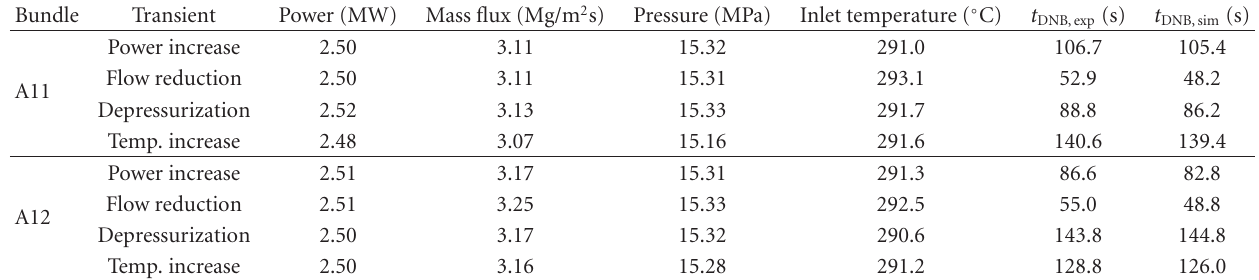
Table 12: Transient initial conditions, predicted and measured DNB